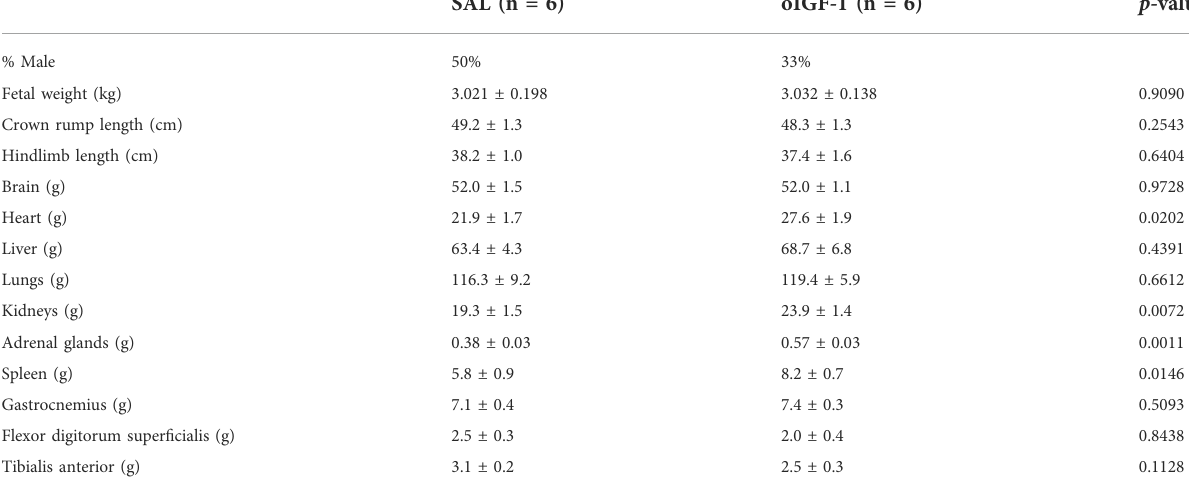
TABLE 2 Fetal body and organ weights after 1-week infusion of oIGF-1 or saline (SAL). SAL (n = 6) oIGF-1 (n = 6) p -value